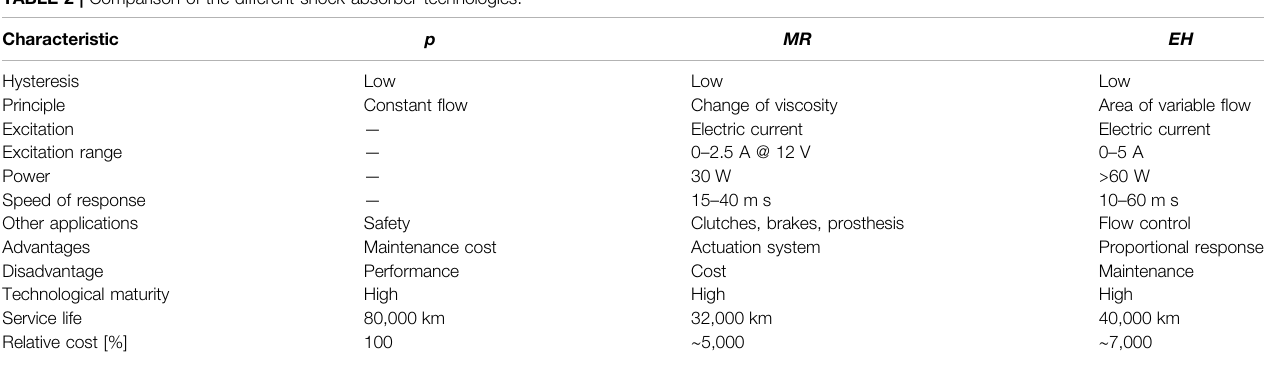
TABLE 2 | Comparison of the different shock absorber technologies.